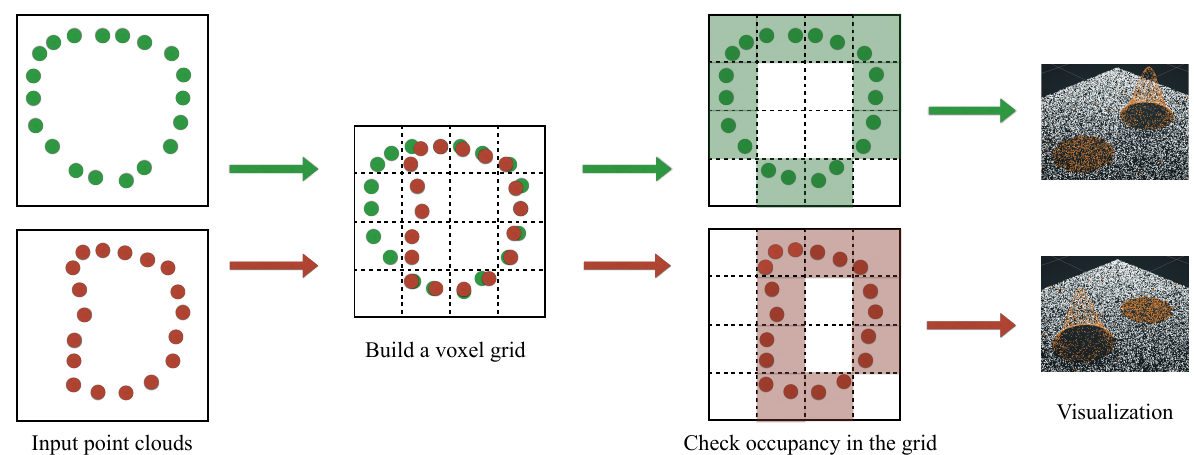
Figure 1. The figure outlines the algorithm to compare the geometry of two point clouds. A voxel grid is built based on the point clouds. Geometry differences of the point clouds can be computed by comparing occupancy status of each voxel with respect to the two point clouds. The rightmost column visualizes the computed geometry differences which are illustrated as orange dots in the